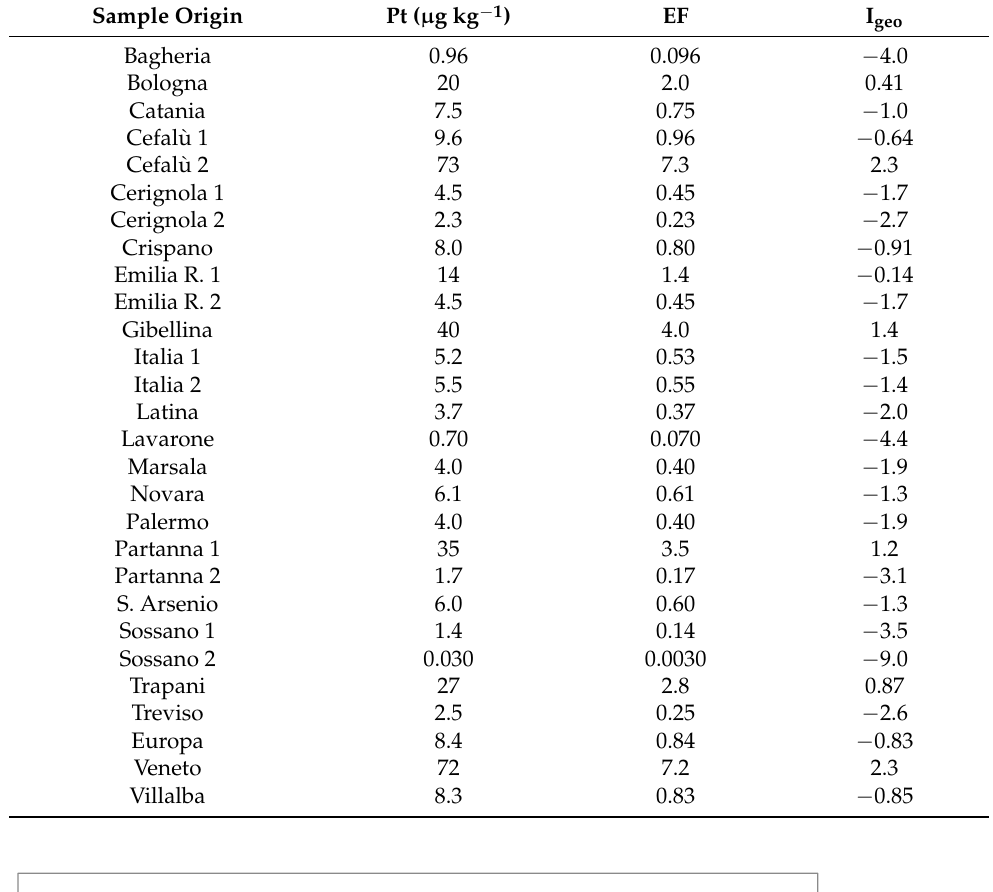
Table 1. Platinum concentrations (µg Kg − 1 ), Enrichment factors (EF), and Geoaccumulation index (I geo ), measured on mushroom samples.